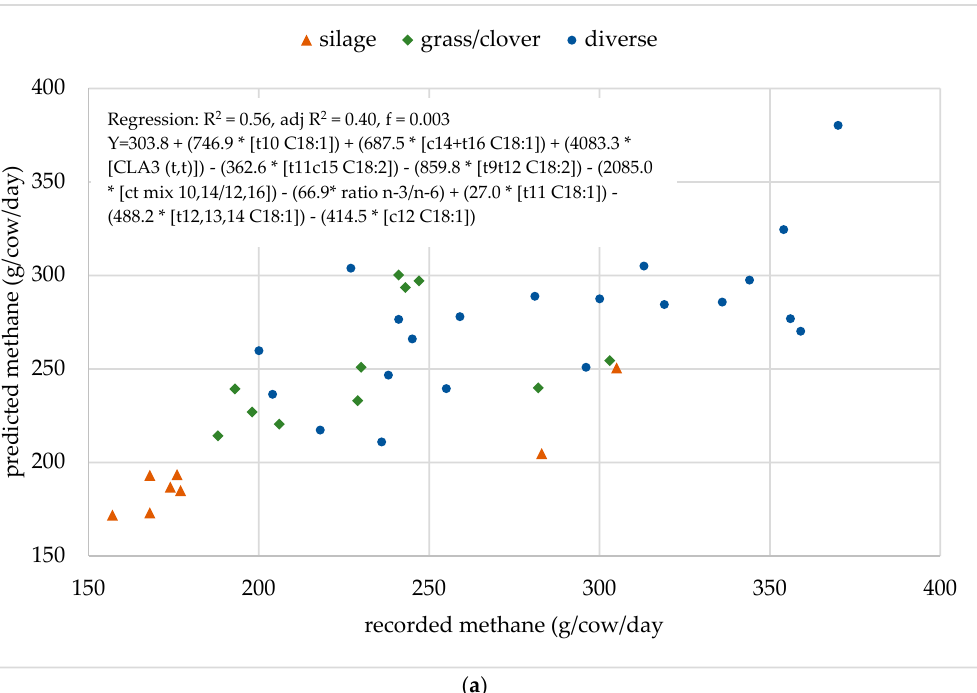
( b ) Figure 2. Measured vs. predicted methane output ( a ) per day and ( b ) per kg energy-cor- rected milk yield, coded according to forage type .